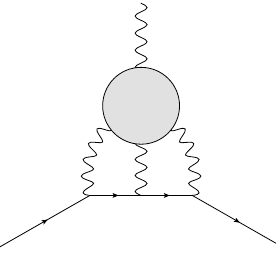
Figure 1. HLbL contribution to the anomalous magnetic moment of the muon ( g a dispersive treatment. In particular, we derived a Lorentz decomposition of the HLbL tensor that manifestly implements crossing symmetry and gauge invariance, with scalar coe(cid:14)cient functions free of kinematic singularities and zeros that ful(cid:12)ll the Mandelstam double-spectral representation. In this framework, we worked out how to de(cid:12)ne unambigu- ously and in a model-independent way both the pion-pole and the pion-box contribution. 1 With pion- as well as (cid:17) -, (cid:17) 0 -pole contributions determined by their doubly-virtual transition form factors, which by themselves are strongly constrained by unitarity, ana- lyticity, and perturbative QCD in combination with experimental data [38{46], we